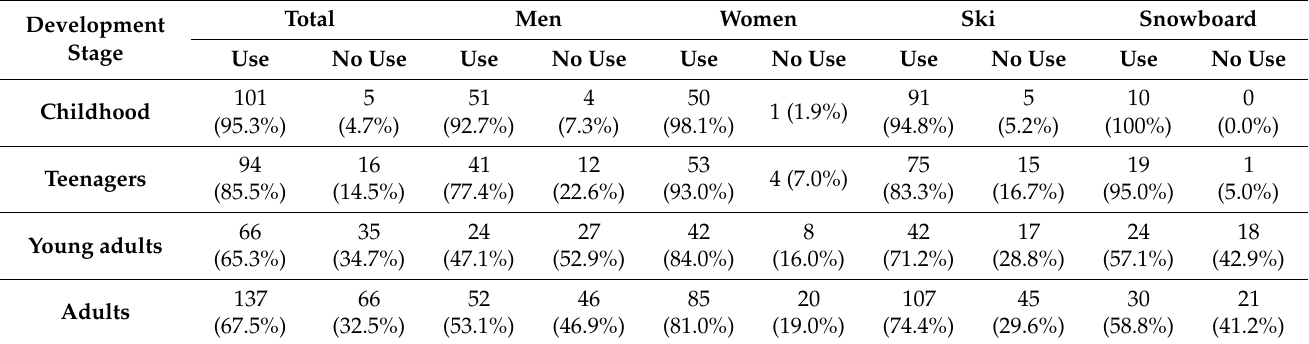
Table 2. Percentage of use of protection regarding development stage and